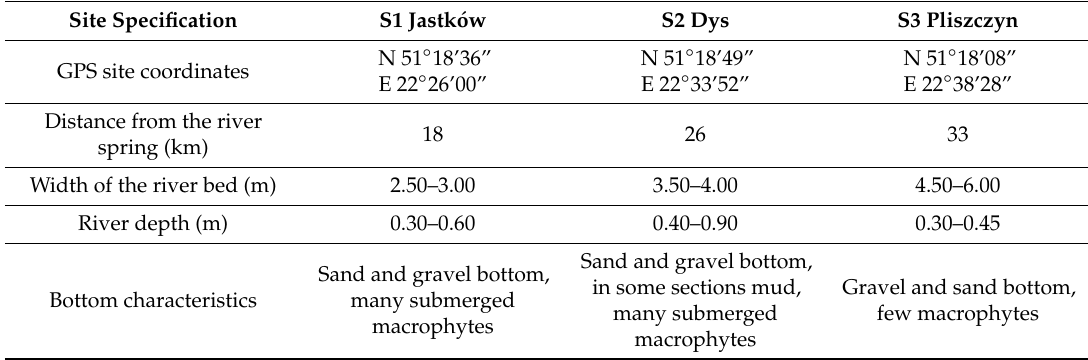
Figure 1. Map showing the location of study area in Europe (A) and Poland (B) and study sites on the Ciemi˛ega River (S1–S3). Table 1. Characteristics and physicochemical water parameters (mean ± SD) † at sampling sites in the Ciemi˛ega River (after Rechulicz [29], altered).